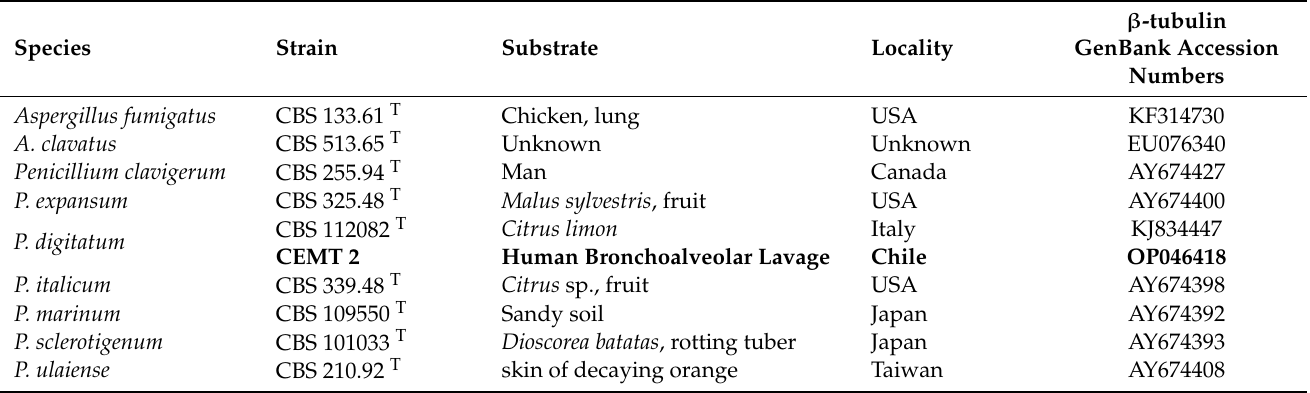
Table 1. Penicillium species included in the phylogenetic study, their respective origin, and GenBank accession